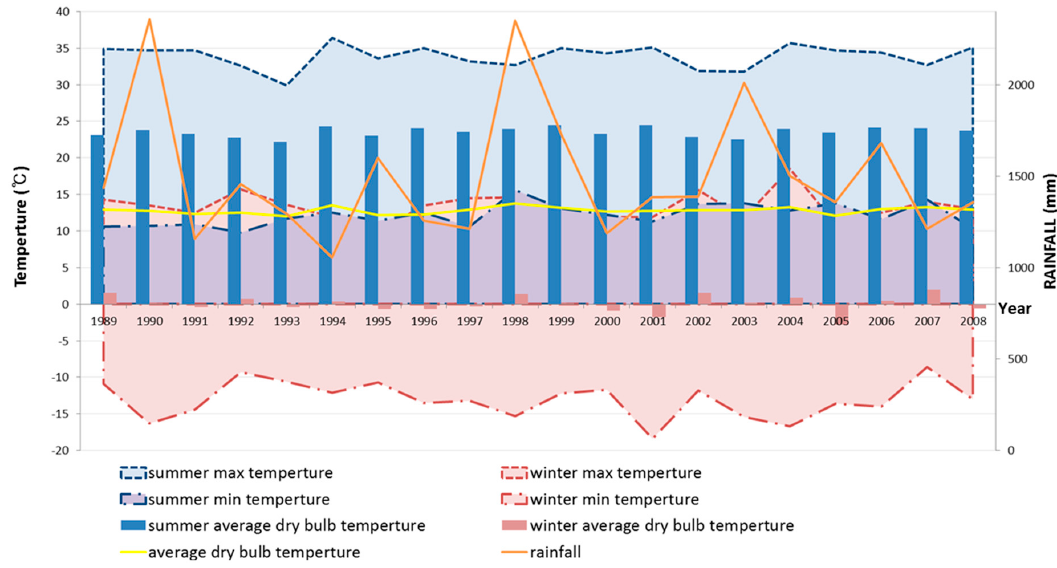
Figure 5. Dry bulb temperatures and rainfall measurements from 1989 to 2008.